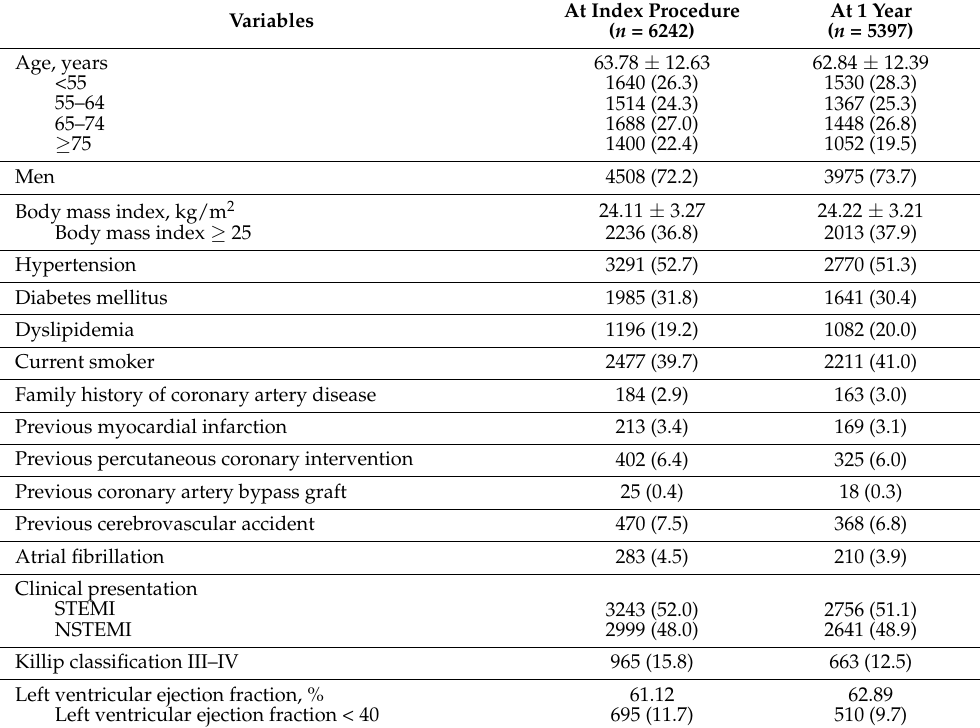
Table 1. Baseline characteristics of the study population at the time of and 1 year after the index percutaneous coronary intervention